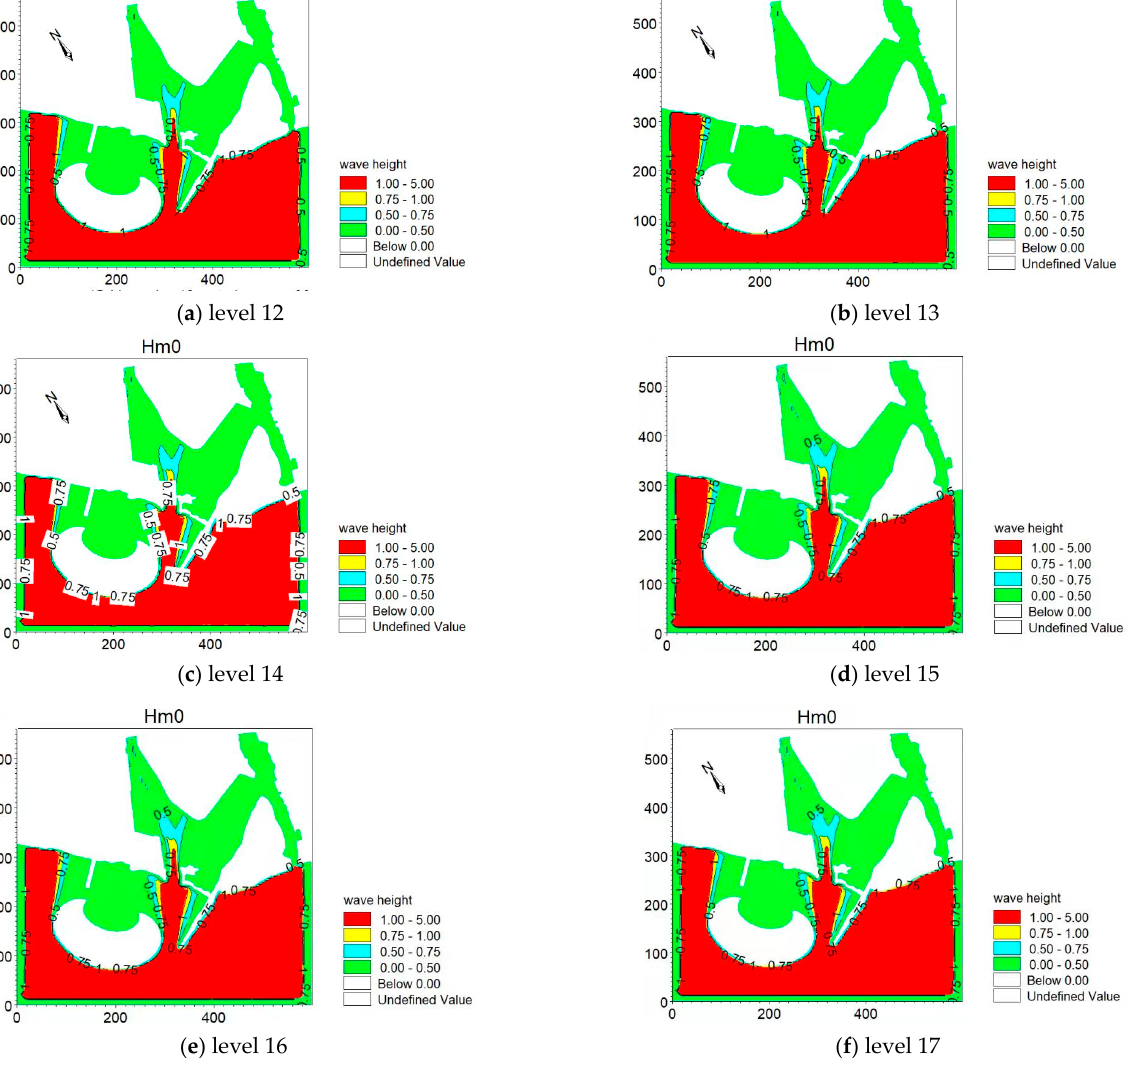
Figure 11. Wave distribution at the berthing area of SYFP during level 12–17 typhoons. ( a ) level 12 ( b ) level 13 ( c ) level 14 ( d ) level 15 ( e ) level 16 ( f ) level